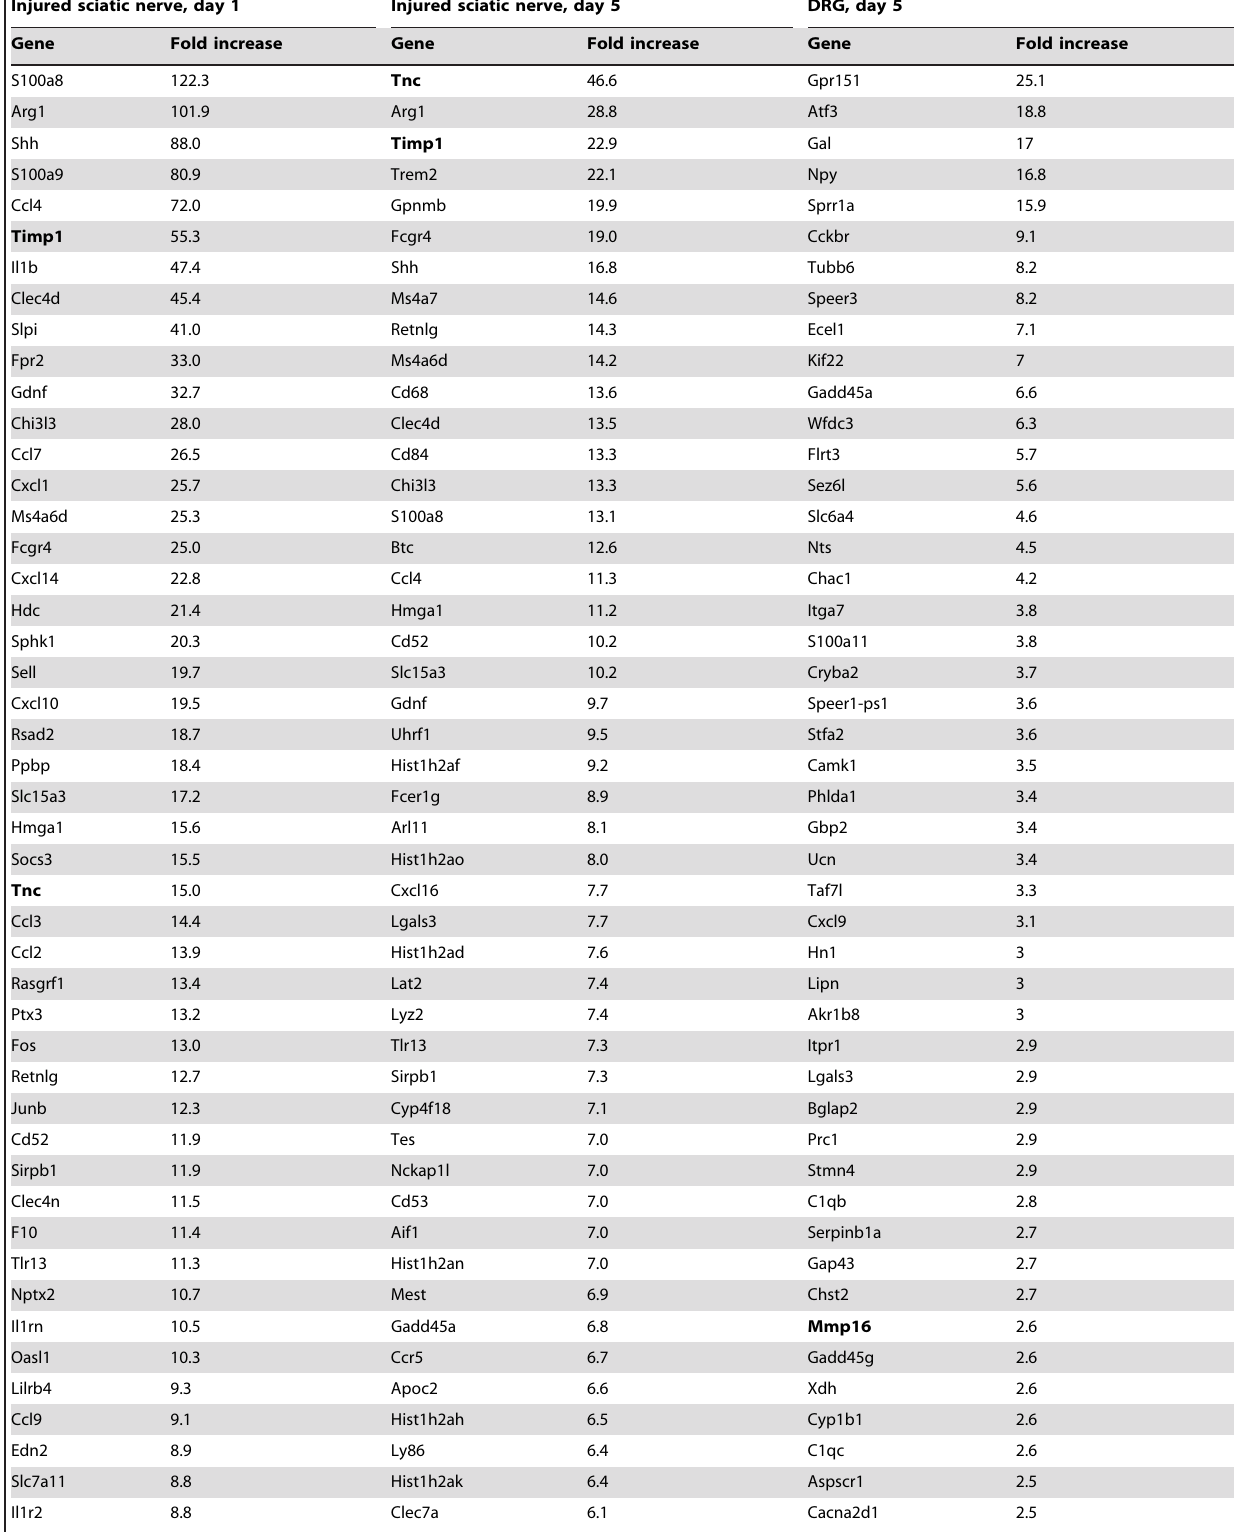
Injured sciatic nerve, day 1 Injured sciatic nerve, day 5 DRG, day